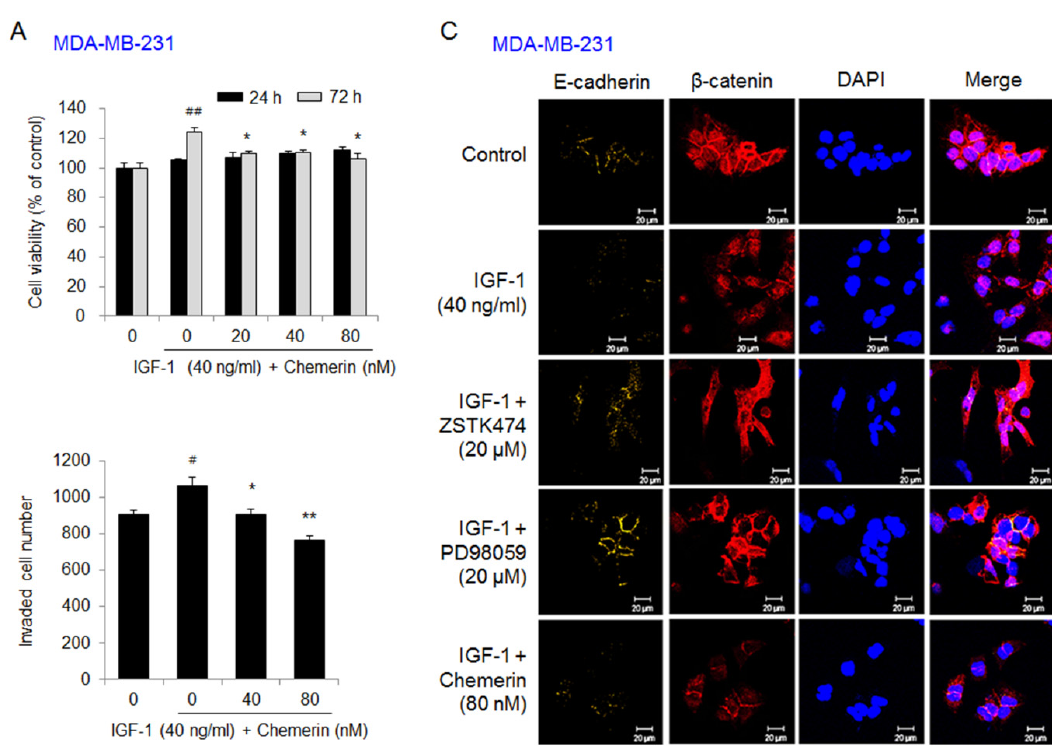
Figure 3. Chemerin suppressed the viability, invasion, and EMT of insulin-like growth factor (IGF)- 1-treated breast cancer cells. ( A,B ) The viability and invasion of ( A ) MDA-MB-231 or ( B ) MCF-7 cells treated with IGF-1 and chemerin for 24 and 72 h. Cell viability was measured by an MTT assay. Cell invasion was determined by counting the number of invaded MDA-MB-231 and MCF-7 cells 24 h